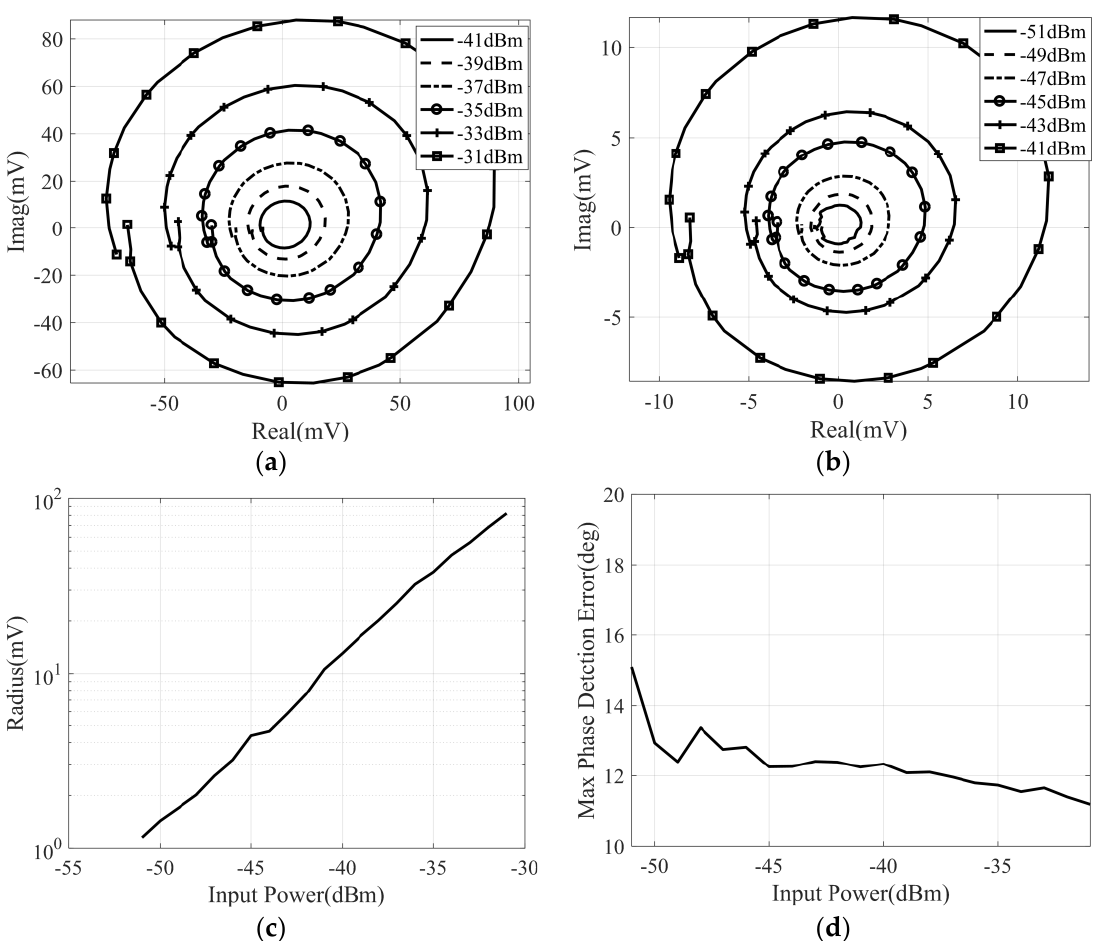
Figure 16. The broadband noise measurement and calibration result of the correlator with input noise power varies from −5 1 dBm to −3 1 dBm: ( a ) measured correlation circle with input power varies from −4 1 dBm to −3 1 dBm; ( b ) measured correlation circle with input power varies from −5 1 dBm to −4 1 dBm; ( c ) the correlation circle radius versus noise power; ( d ) the variation in maximum phase detection error with input power.